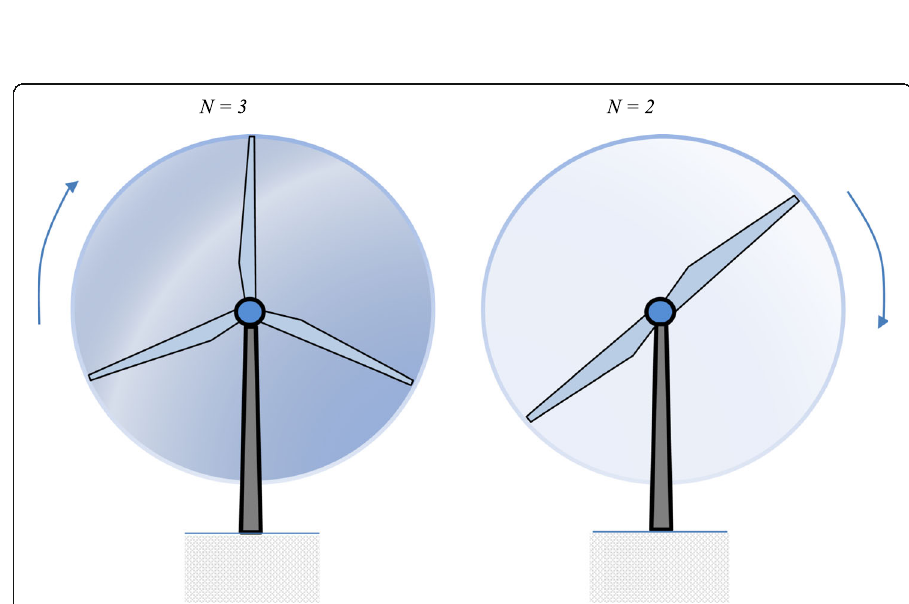
Fig. 4 Illustration of rotor solidity of a wind turbine ( a ) three blades ( b ) two